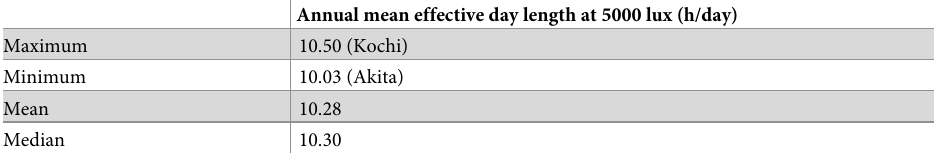
Table 2. Basic statistics for climatic variables.